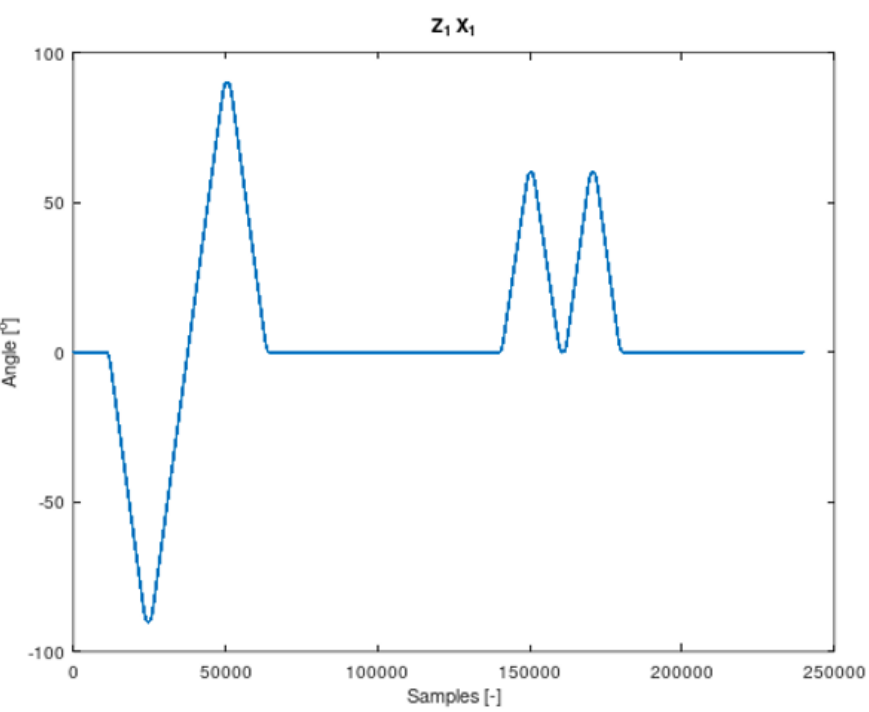
Figure 4. The angle set on the robot axis to which the coordinate system is assigned z 1 x 1 in Figure 3. Data from FANUC robot encoders collected using the apparatus.